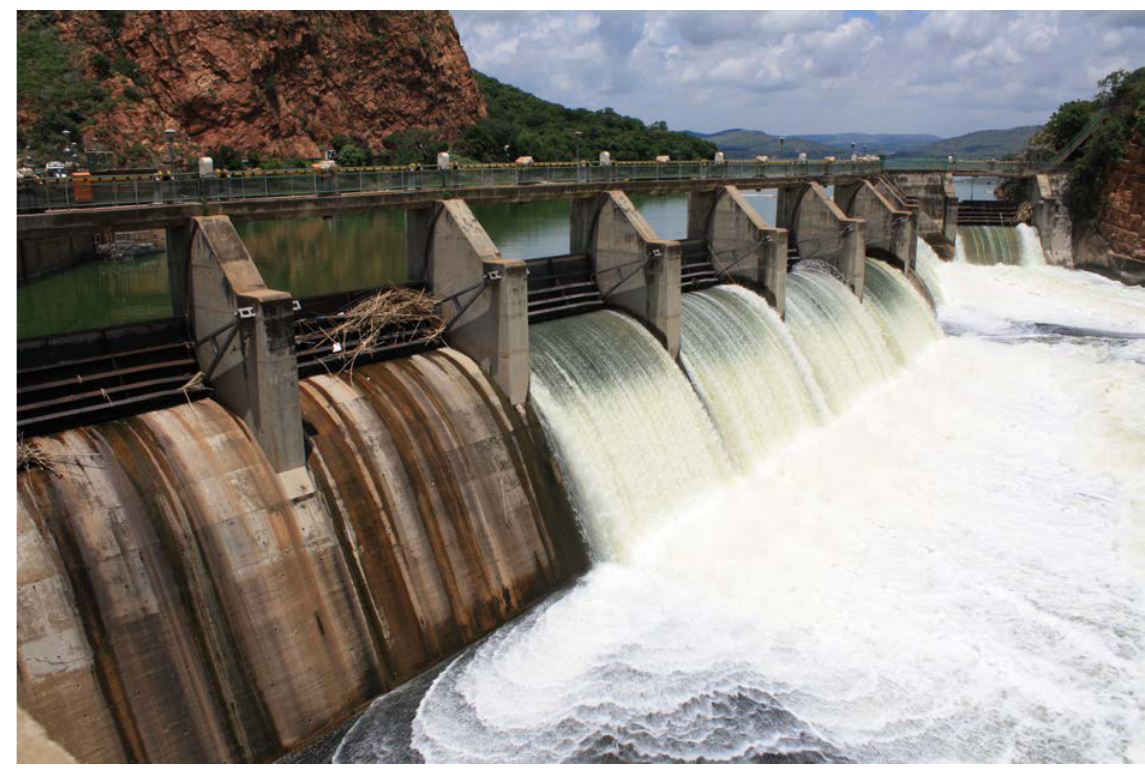
Illustration 4: The Hartbeespoort Dam was originally completed in 1923 and raised through the addition of sluices (pictured) in 1970.